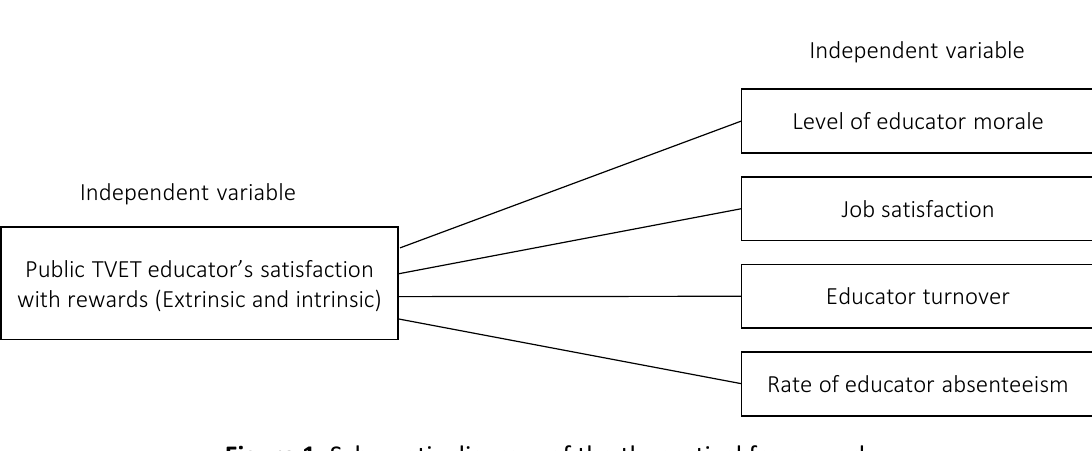
Source: Adapted from Sekaran and Bougie (2016, p.